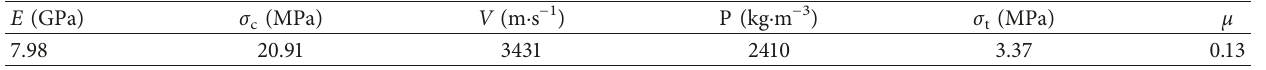
Table 1: The physical and mechanical parameters of sandstone.